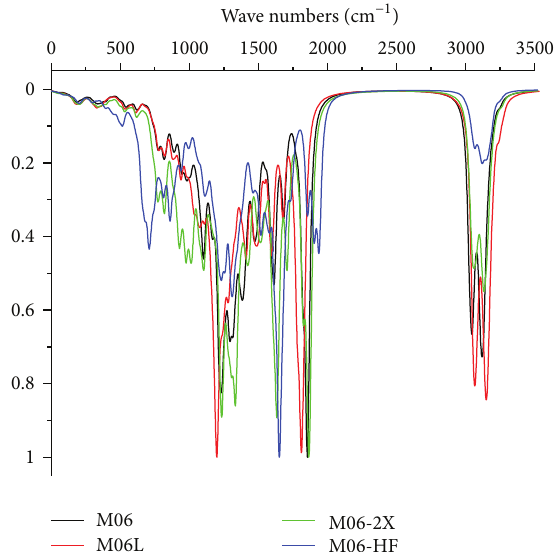
F 2: Infrared spectra of the chlorophyll a molecule calculated with the M06, M06L, M06-2X, and M06-HF density functionals and the MIDIY and DGDZVP basis